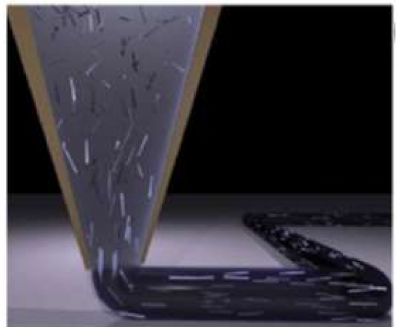
Figure 2. Short fiber alignment during the extrusion process [26].